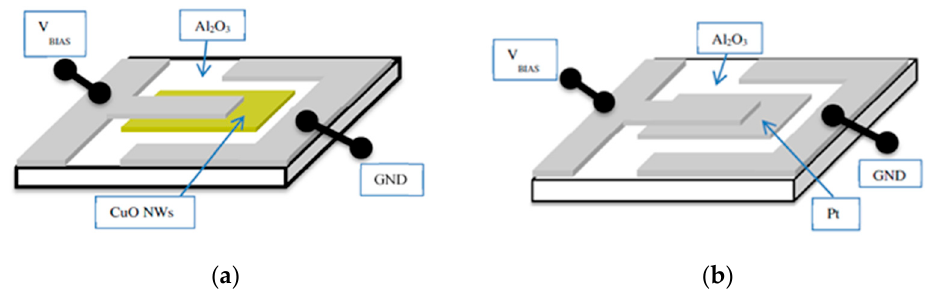
Figure 6. Planar SI sensor architectures built up on ceramic substrates with bottom-surface heaters: ( a ) Planar device featuring a CuO emitter layer (yellow) opposite to a Pt counter electrode (grey); ( b ) symmetrical reference device featuring both emitter and collector electrodes consisting of thin-film Pt. Reprinted from [28].